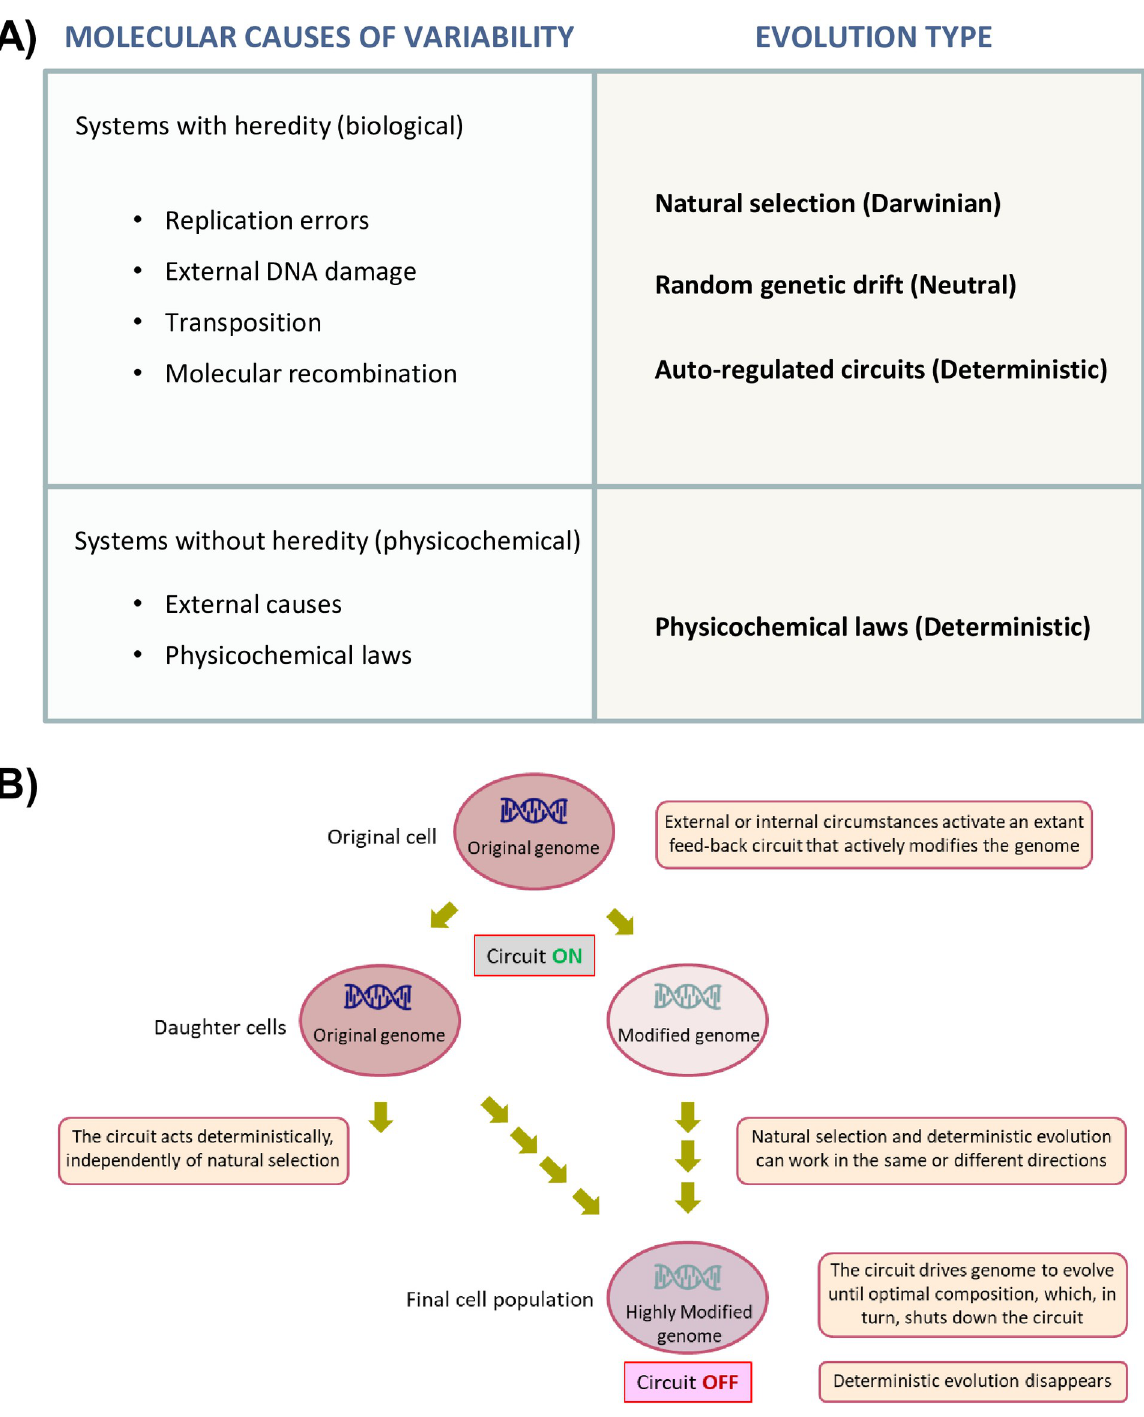
Fig 3. Deterministic evolution features in living systems. A) Evolving systems need to develop a molecular source of variability and a downstream mechanism that determines the type of evolution. Deterministic evolution occurs in other non biological systems, follows physical or chemical laws in the absence of heredity, and independently of the selective pressures that conduct most biological evolution. B) Some extant feedback circuits developed for any specific purpose can be triggered by internal or external changes, and in such a way that it leads to deterministic